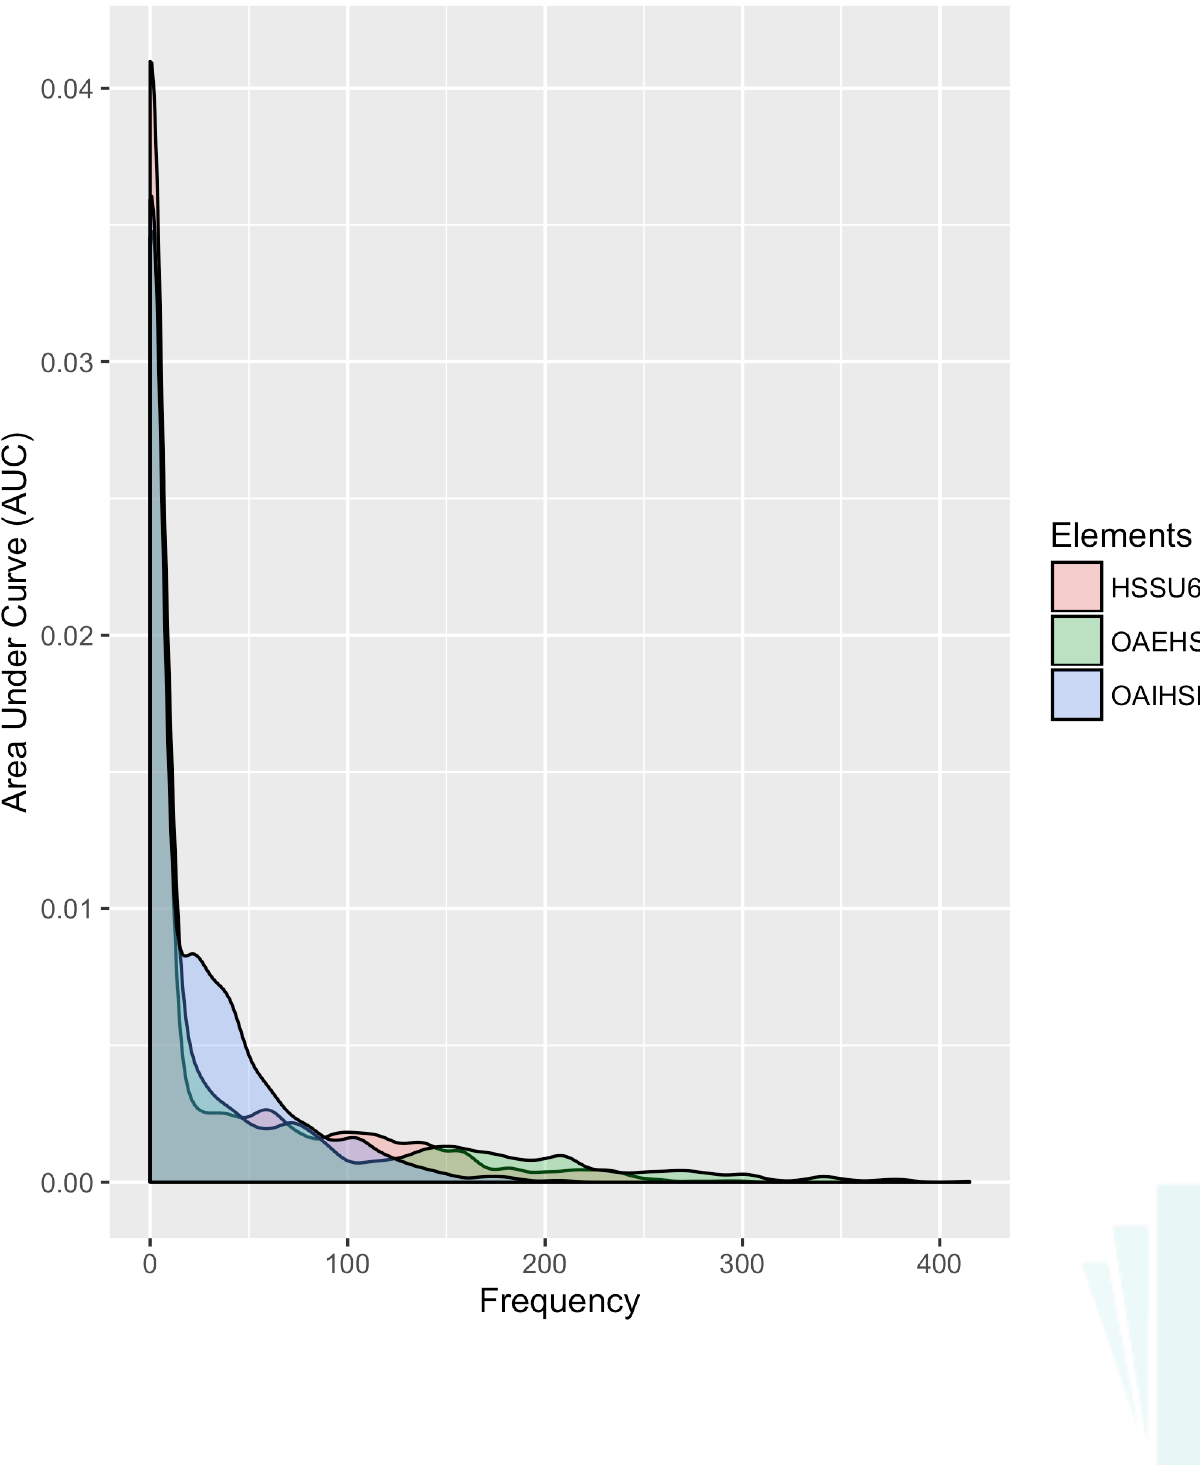
Figure 11: Density plots comparing the three service elements over the period 2010 to